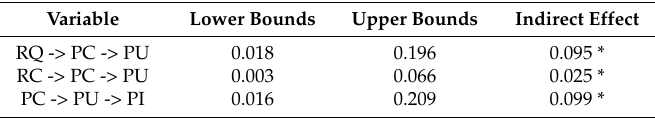
Table 6. Summary of mediating analysis.